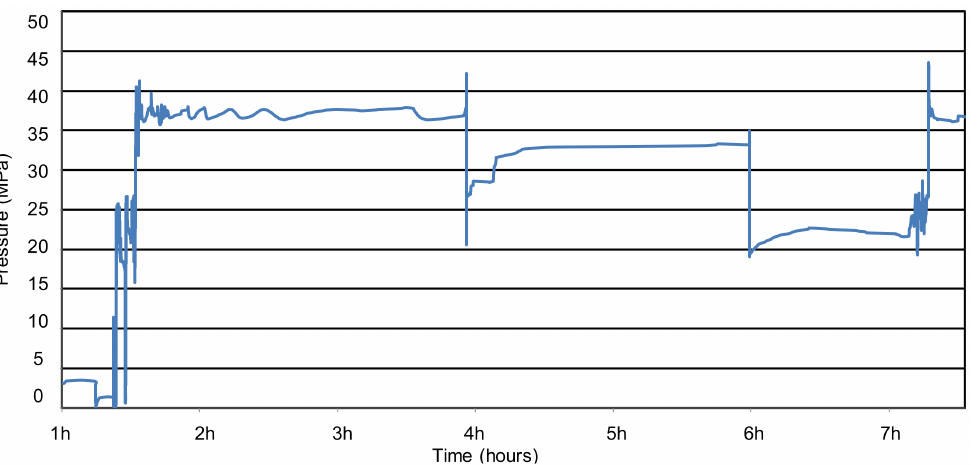
Figure 7. Measurement analysis for the obtained pressure during the operation of the floor support actuator: section expansion time (a), working support (b), the moment when the actuator is damaged (c), and loss of required pressure due to damage (d).